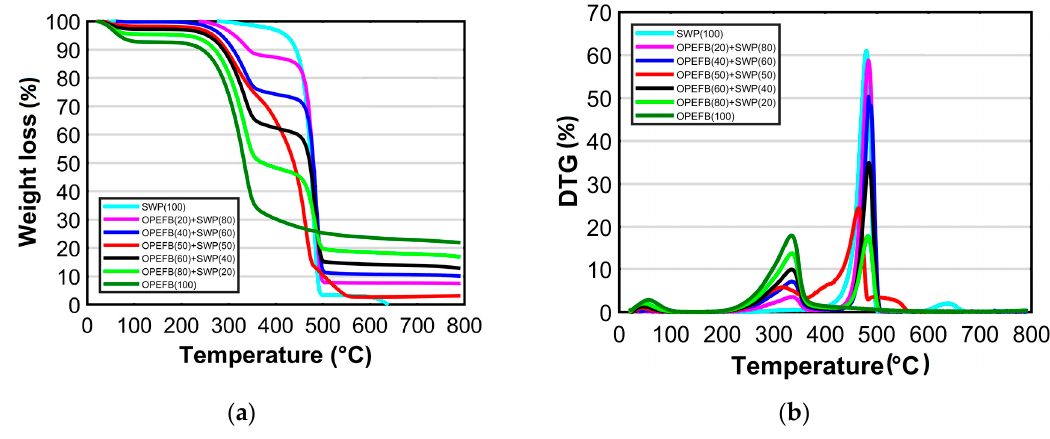
Figure 2. ( A ) TG, and ( B ) DTG curves for OPEFB and SWP samples and their blends at heating rates Figure 2. ( a ) TG, and ( b ) DTG curves for OPEFB and SWP samples and their blends at heating rates of of 20 °C min -1 . 20 ◦ C min − 1